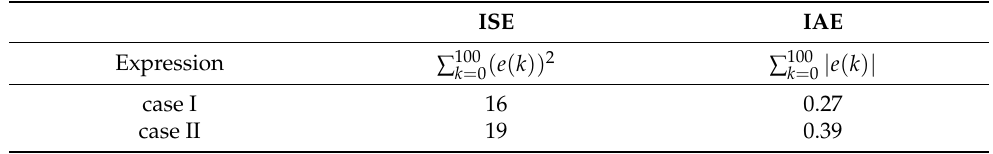
Table 2. Comparison of e ( k ) for k ∈ [ 0,100 ]